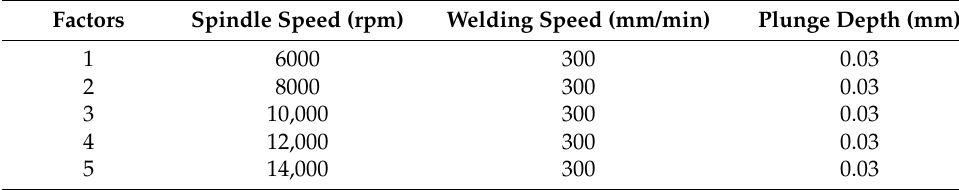
Figure 3. Tensile specimen size. Table 2. Welding process